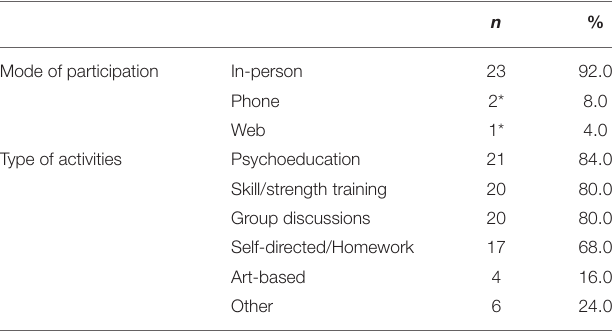
TABLE 6 | Mode of participation and type of activities of positive psychology programs reviewed ( n =